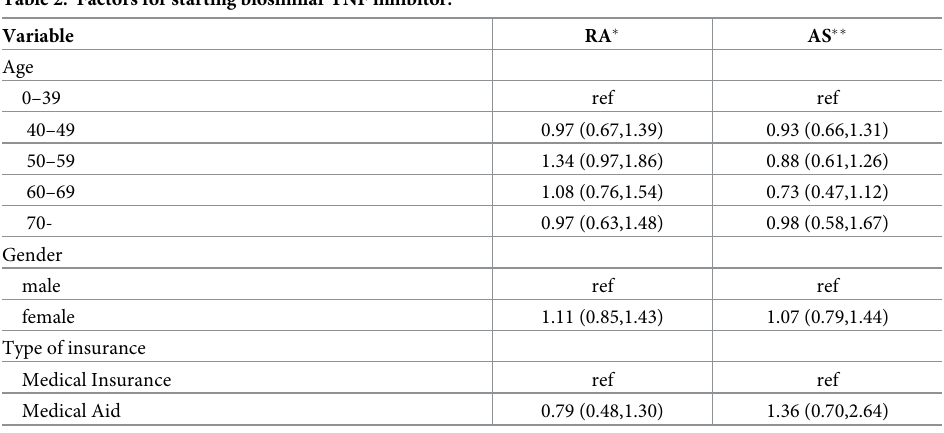
Table 2. Factors for starting biosimilar TNF